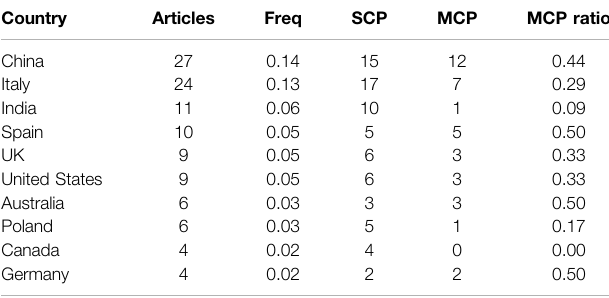
TABLE 5 | Top corresponding authors ’ countries. Country